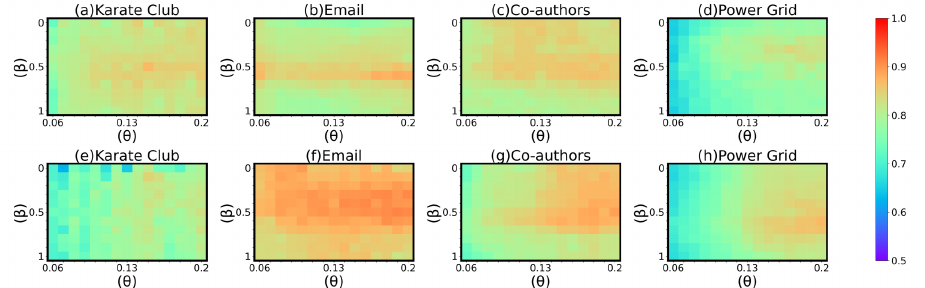
Figure 6. The Kendall’s τ between the rankings obtained by our methods and node influence simulated by the SIR model: ( a – d ) measured by DNSD; and ( e – h ) measured by DNSD + . α is set to 0.5. β is set to 0–1 with the interval